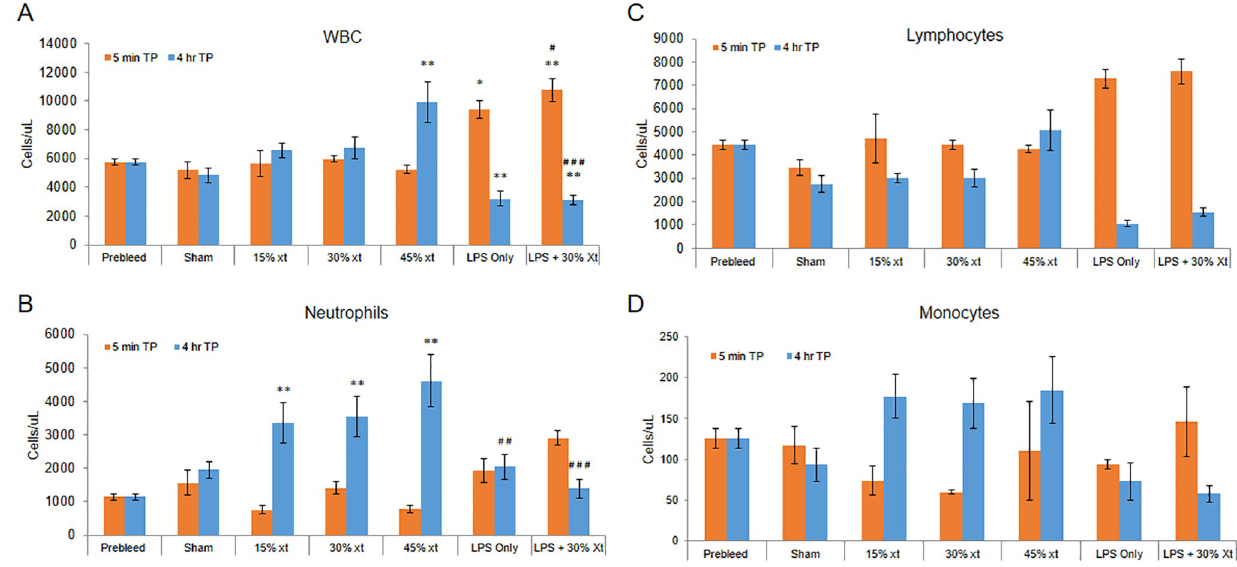
Fig 3. LPS induces leukopenia. Blood was collected from rats before addition of LPS or transfusion (0 min, pre-bleed time point (tp)), (n = 64). Five minutes and 4 hour later, blood was again collected from sham rats (5 min (n = 5) and 4 hours (n = 8)), rats transfused with 15% (5 min (n = 3) and 4 hours (n = 6)), 30% (5 min (n = 3) and 4 hours (n = 9)) or 45% (5 min (n = 3) and 4 hours (n = 6)) human erythrocyte transfusion (xt), LPS only (5 min (n = 4) and 4 hours (n = 10)) or LPS+30% (5 min (n = 3) and 4 hours (n = 13)) transfusion. (A) White blood cells (WBCs). (B) Neutrophils. (C) Monocytes. (D) Lymphocytes. Data are means and standard error of the mean. Statistical analysis was performed using an ANOVA followed by Student t -test. � denotes P � 0.02, �� denotes P � 0.005, respectively, compared to the pre-transfusion control at the corresponding timepoint. # denotes P < 0 . 05 , ## denotes P < 0 . 01 and ### denotes P < 0 . 001 , respectively, compared to 30% xt at the corresponding timepoint.